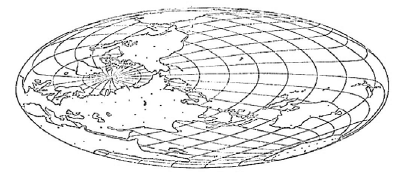
Fig. 2. Two-point azimuthal equidistant